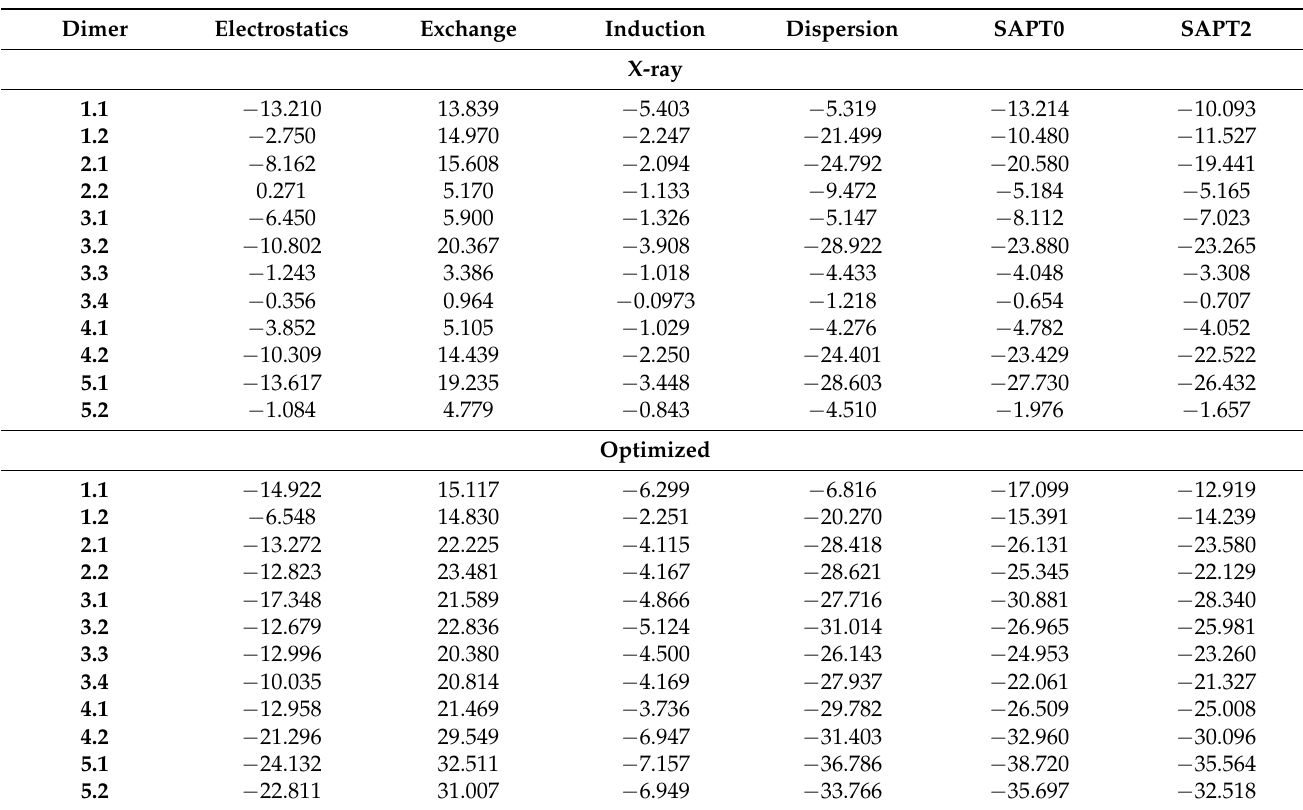
Table 5. SAPT interaction energy partitioning obtained at the SAPT2/aug-cc-pVDZ and SAPT0/aug- cc-pVDZ levels of theory (kcal/mol) for dimeric structures (see Figure 4) taken from the X-ray data and optimized at the PBE-D3/aug-cc-pVDZ level of theory in the gas phase. The first digit in the structure code designates the studied compound and the second digit denotes the dimer type,